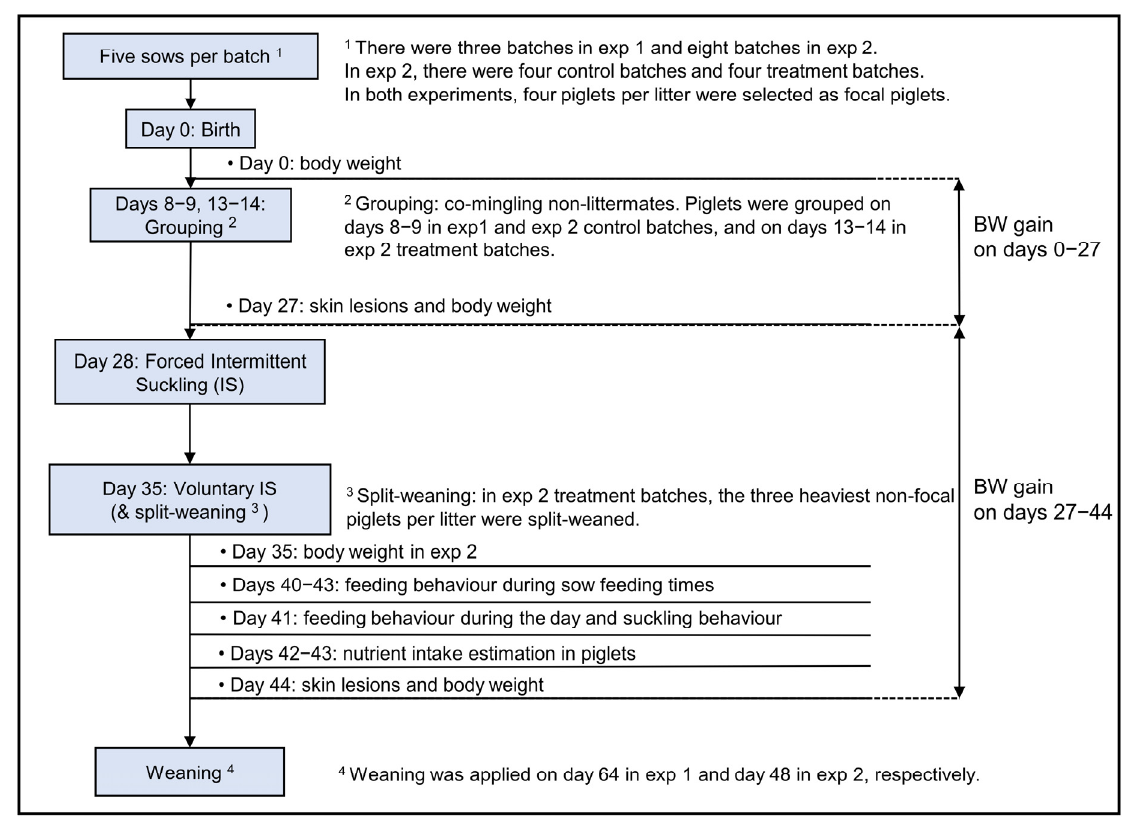
Figure 1. The time schedule of the experimental setup of sows and piglets during lactation in the multi-suckling system.